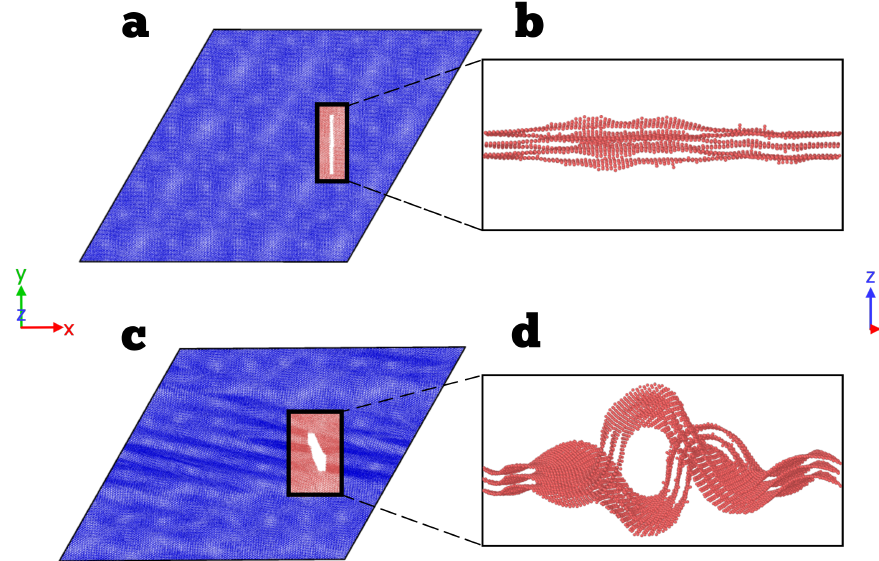
Figure 10. Crack site: ( a ) top-down view, strain = 0; ( b ) side view, strain = 0; ( c ) top-down view, strain = 0.019; ( d ) side view, strain = 0.019. The conditions of the tensile simulation are follows: temperature T = 300 K, pressure P = 0.0001 GPa, strain rate = 1 × 10 9 s − 1 , crack length (2a 0 ) = 8